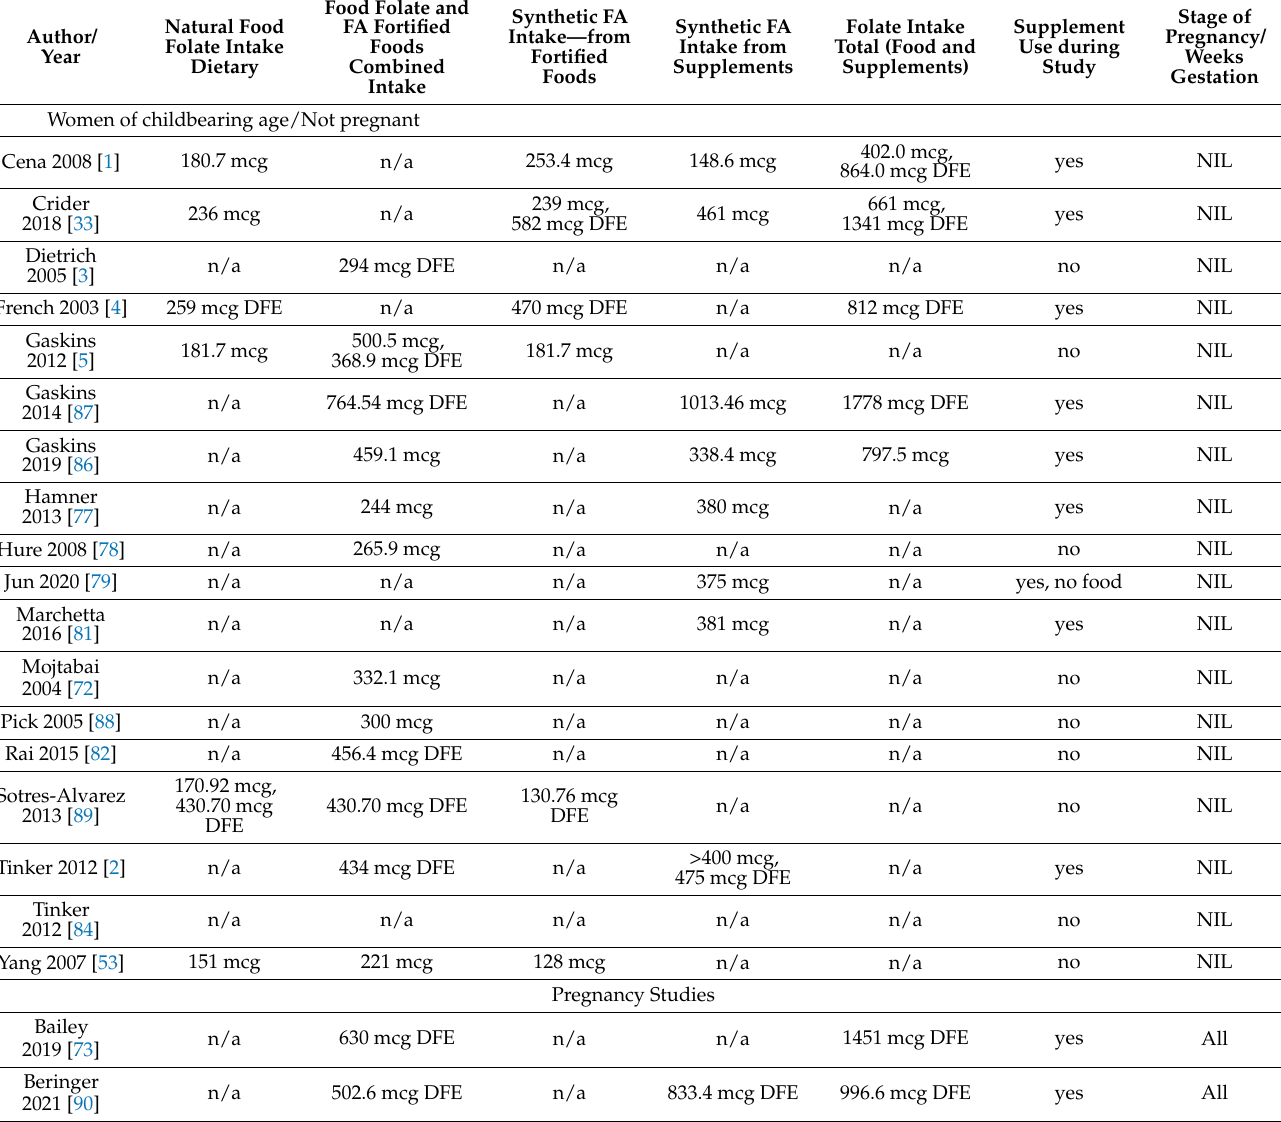
Table 3. Folate intake per day by natural food intake, fortified food intake, supplements and